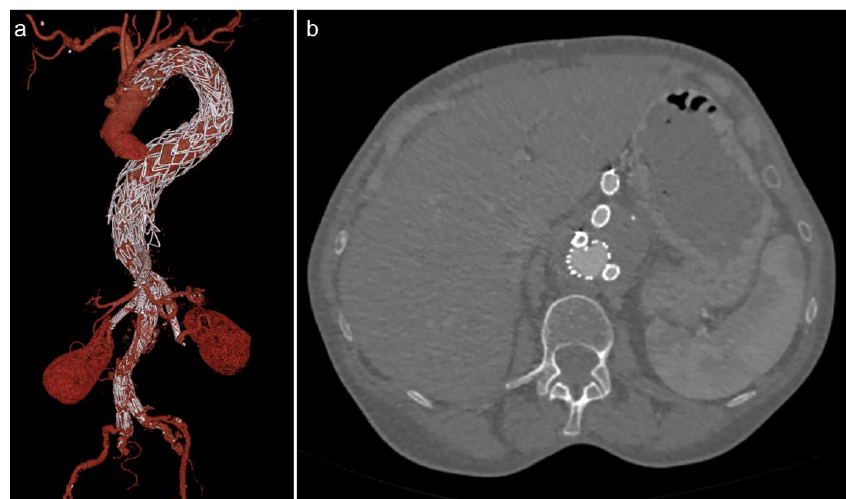
Figure 4. ( a ) Volume-rendered image of a CT angiogram post-FEVAR with thoracic stent grafts for a thoracoabdominal aneurysm. ( b ) Axial slice of the same CT angiogram showing stent grafts in four aortic branches (coeliac, superior mesenteric, and bilateral renal arteries).